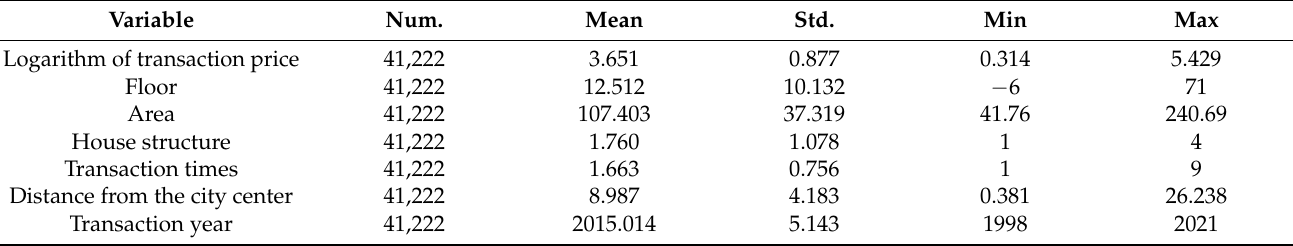
Table 2. Descriptive statistics of